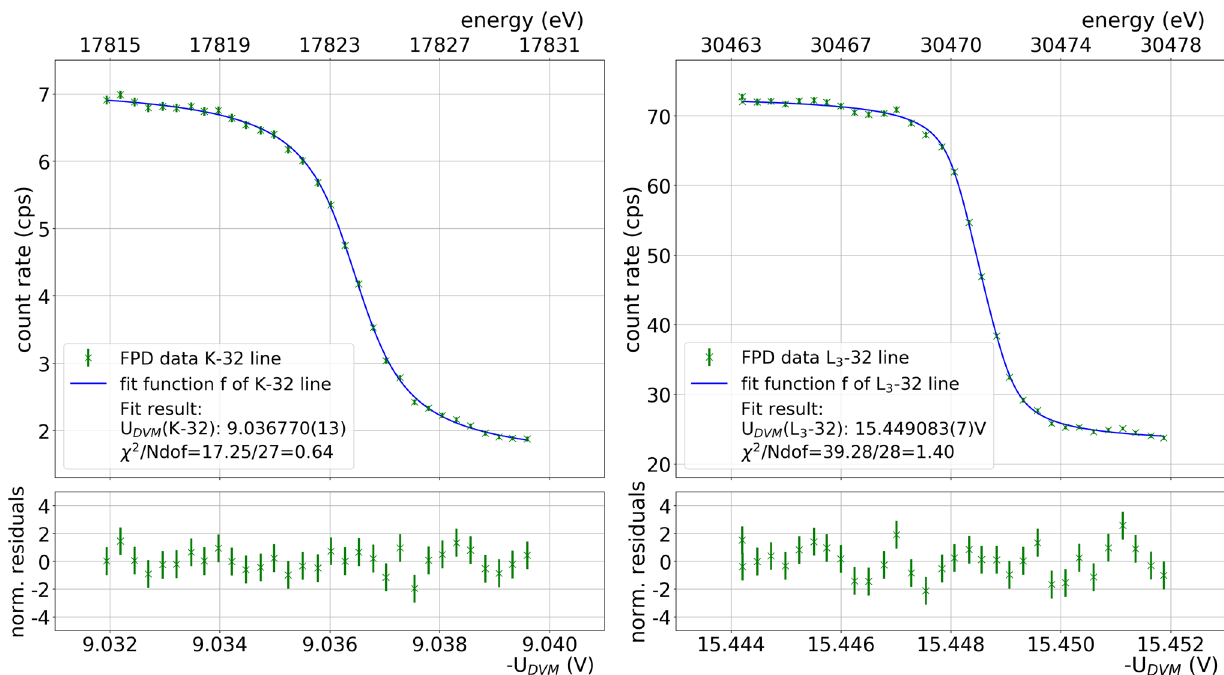
Fig. 2 Averaged K-32 (left) and L 3 -32 (right) data of the innermost 40 detector pixels with a four-parameter line fit to visualize the more com- plex constrained fit of the 40 individual pixels (see text). The denoted linepositiondoesnotincludetheworkfunctiondifference ΔΦ between